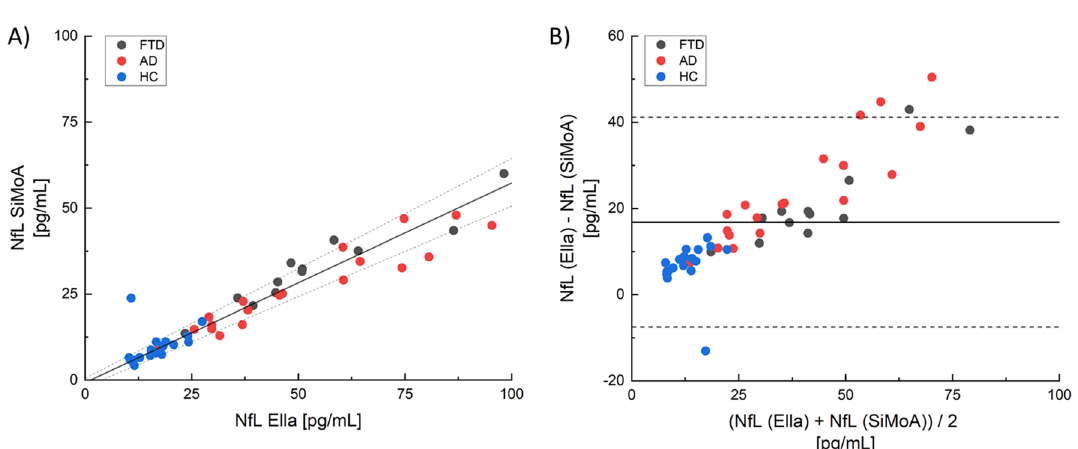
Figure 2. ( A ) Passing–Bablok regression analysis of NfL concentration measured by Ella and SiMoA. Solid black line: Passing–Bablok regression fit. The dashed lines represent 95% limits of agreement. ( B ) Bland– Altman plots comparing the agreement between plasma NfL levels measured by Ella and SiMoA. The solid line represents the difference between the assays. The dashed lines represent 95% limits of agreement. Each data point represents an individual subject analysed (Blue: HC; Red: AD; Dark grey: